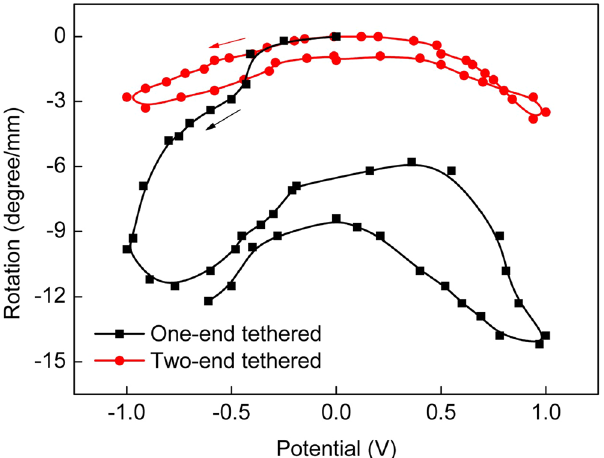
Figure 2. Schematic plot of the torsional behavior of the CNT yarn when immersed in the electrolyte and actuated by the electric potential, clearly demonstrating the reversible rotation in the two-ended tethered CNT yarns. The black line represents the irreversible rotation of the one-ended tethered CNT yarns. This figure was redrawn from Figure S2 in the literature 7 .